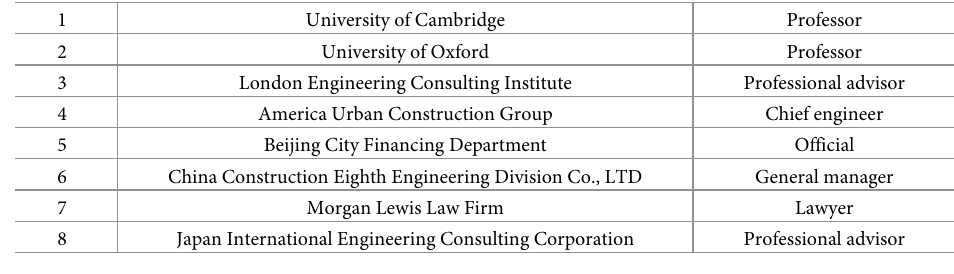
Table 6. Information of the experts.